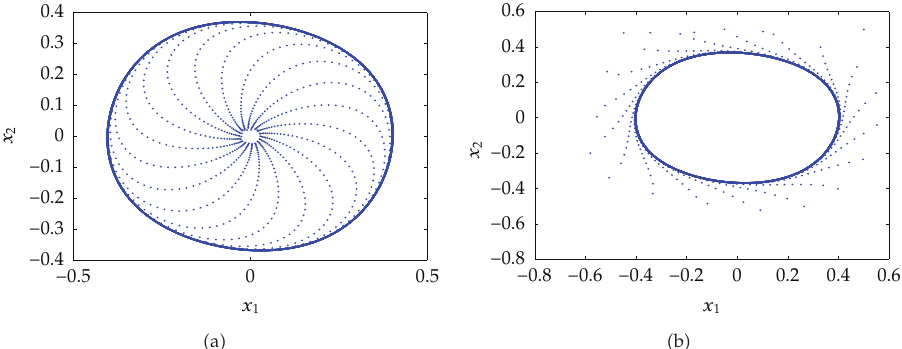
,x (cid:6) for system (cid:4) 4.1 (cid:6) with initial condition (cid:4) 0.6,0.6 (cid:6) and d 1 2